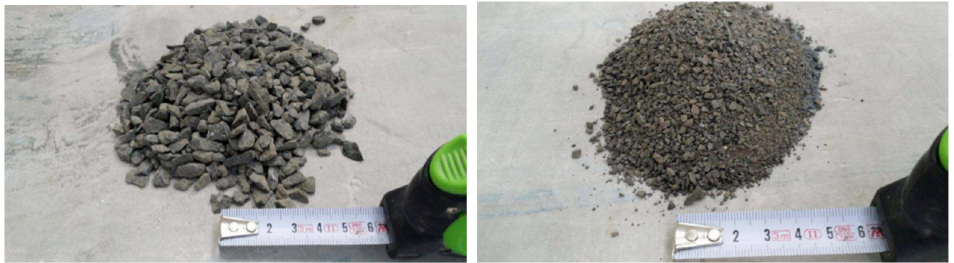
Table 1. Mix design with corundum and basalt aggregates.